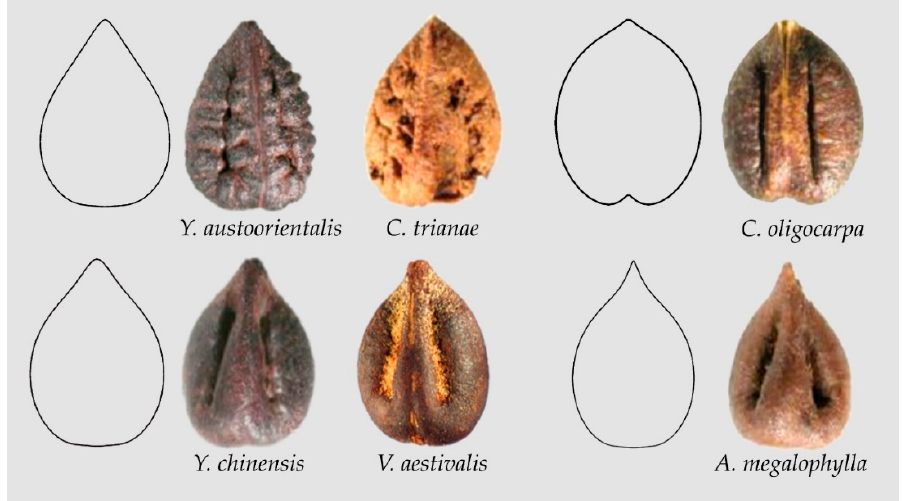
Figure 8. Models YAU1, COL1, VAE1 and AME1 with their respective seeds. Yua austro-orientalis and Cissus trianae (YAU1), Cayratia oligocarpa (COL1), Yua chinensis and Vitis aestivalis (VAE1) and Ampelopsis megalophylla (AME1).